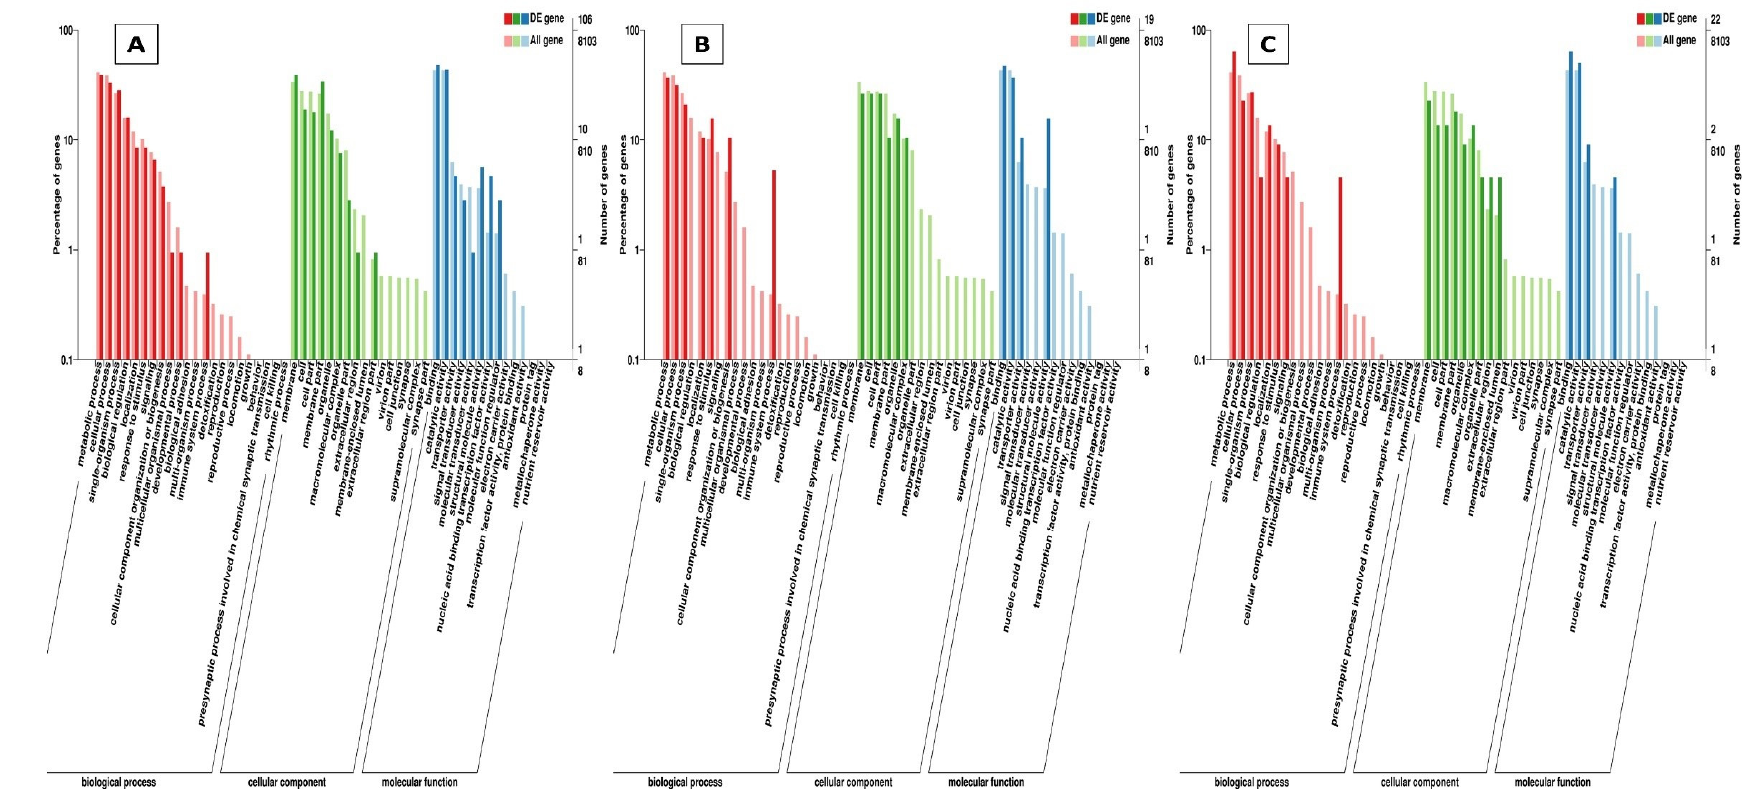
Figure 9. Gene Ontology (GO) classifications of differentially expressed genes. The differentially expressed genes were grouped into three hierarchically stretched GO terms, biological process, cellular component and molecular functions. Control vs B. bassiana (Control vs. BB) ( A ); Control vs B. bassiana + T. asperellum (Control vs. BB+TH) ( B ) and Control vs T. asperellum (control vs. TH) ( C ).